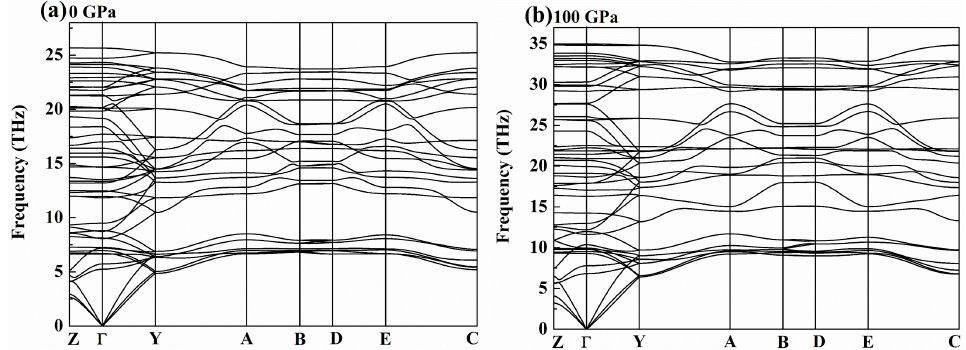
Figure 2. Phonon dispersion curves of the C 2/ m -ZrB 3 at 0 GPa ( a ) and 100 GPa ( b ).